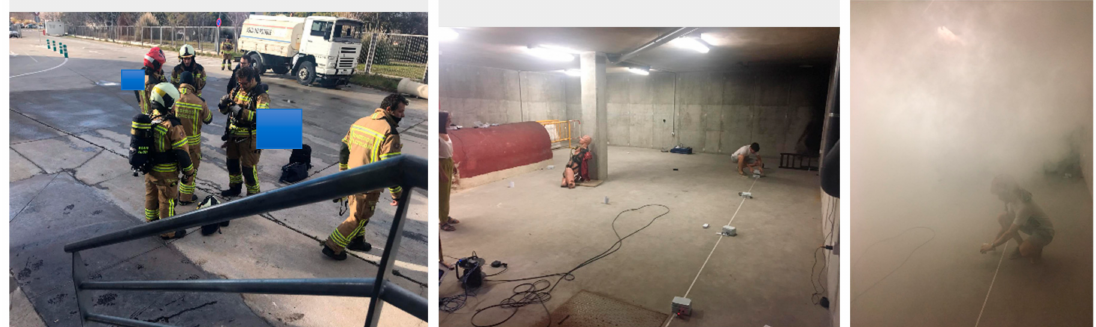
Figure 9. Pictures were made during the evaluation with the firefighter teams of the USC-Alcorc ó n (Unified Service